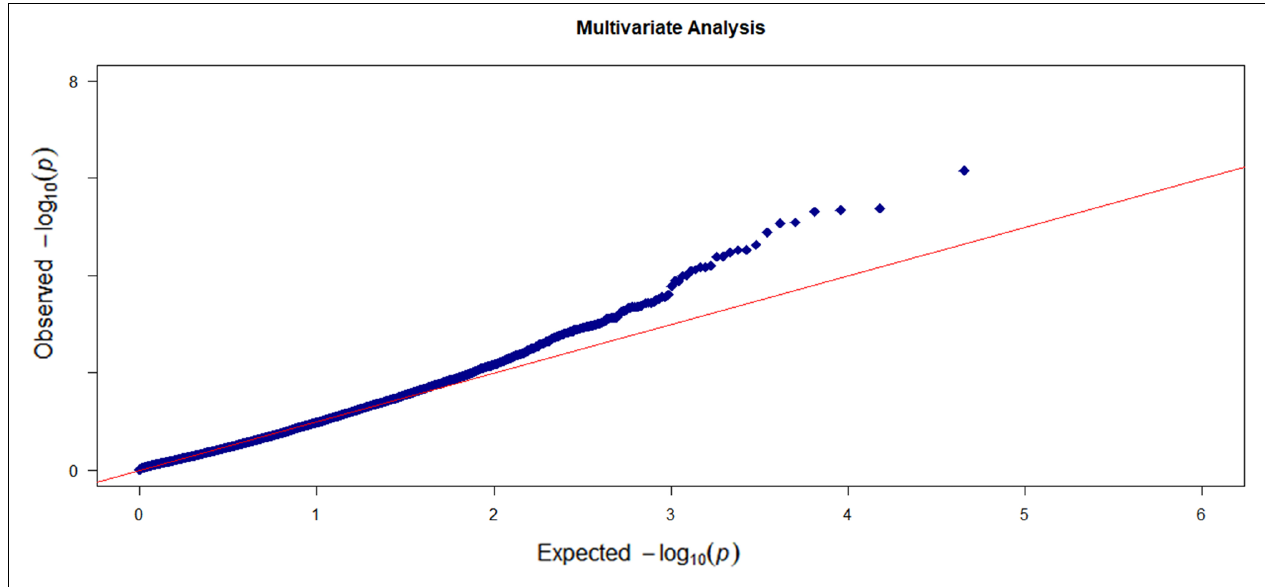
FIGURE 4 | The Q – Q plots of the observed –log10 ( p -value) versus the expected –log10 ( p -value) for the five cortical regions based on the multi-trait